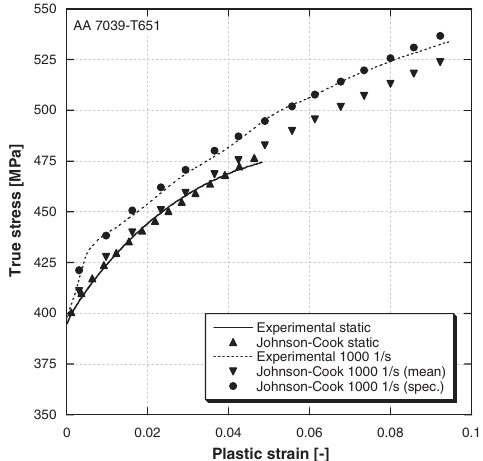
Fig. 14. Johnson-Cook fit for AA 7039-T651. well fitted, the strain-rate sensitivity doesn’t fit very